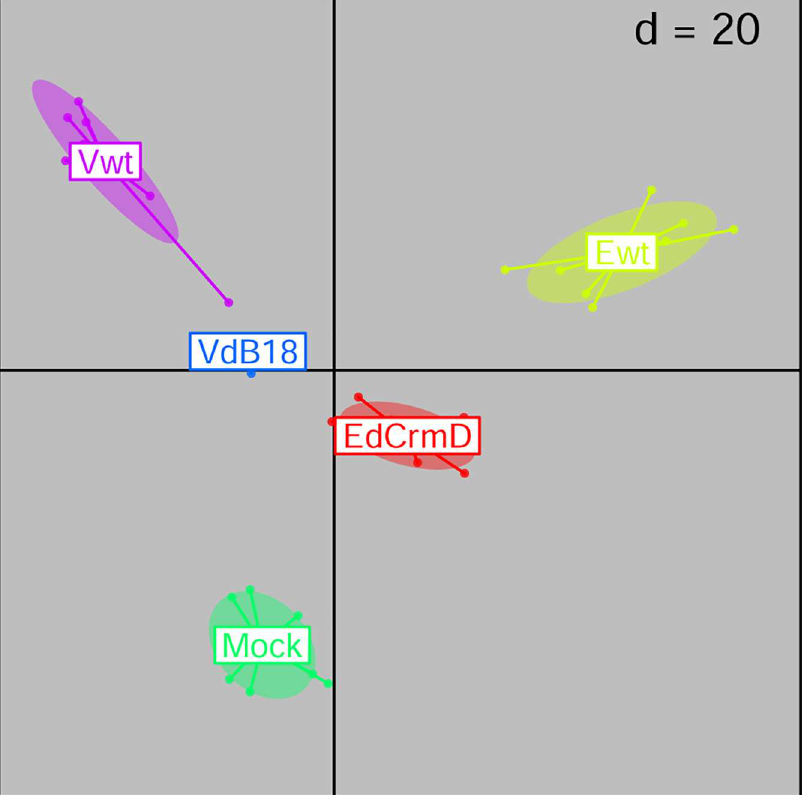
collectivevariances.